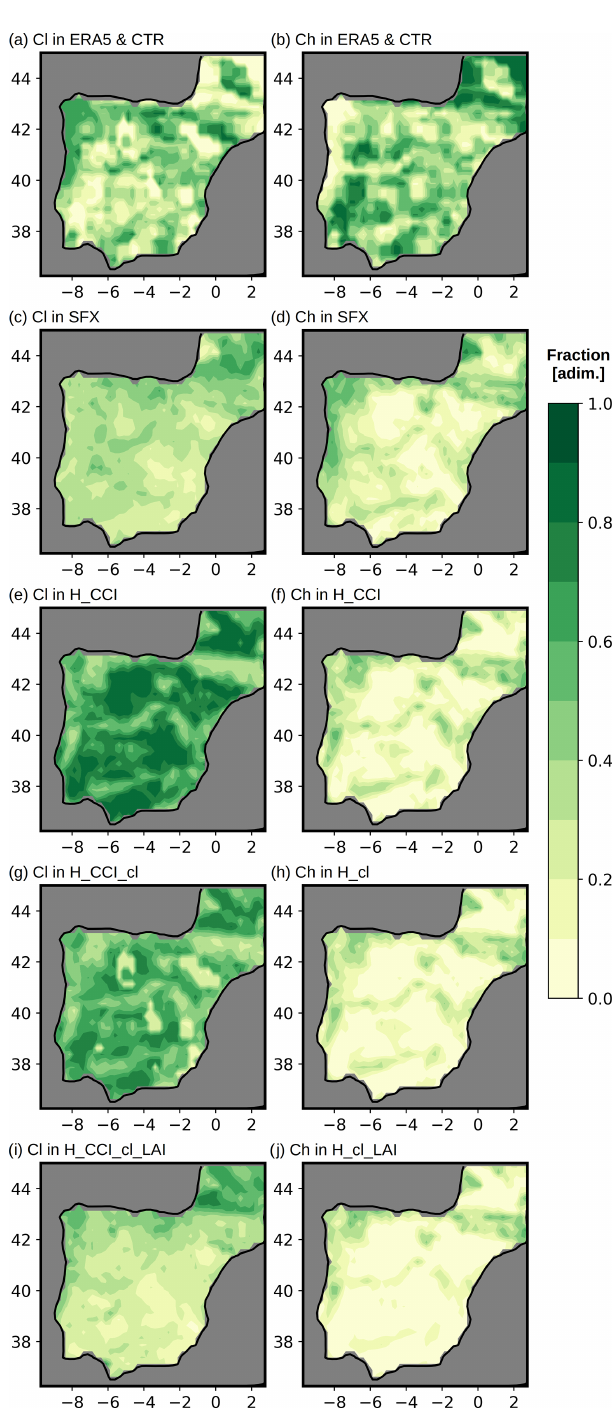
Figure 5. Fraction of low-vegetation (Cl; left column) and high- vegetation (Ch; right column) coverage averaged over JJA. From top to bottom, the panels represent Cl and Ch in CTR (which is identical to ERA5), SFX, H_CCI, H_CCI_cl, and